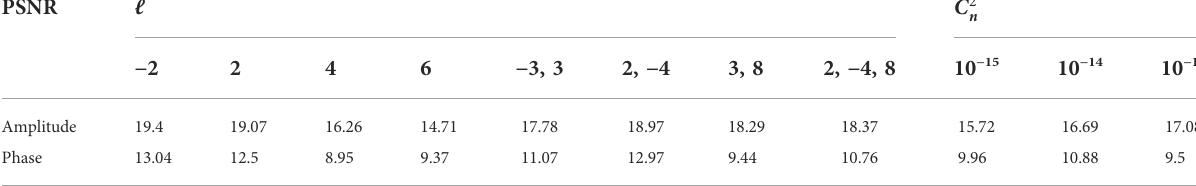
TABLE 1 Peak signal-to-noise ratio of simulation and experimental results.